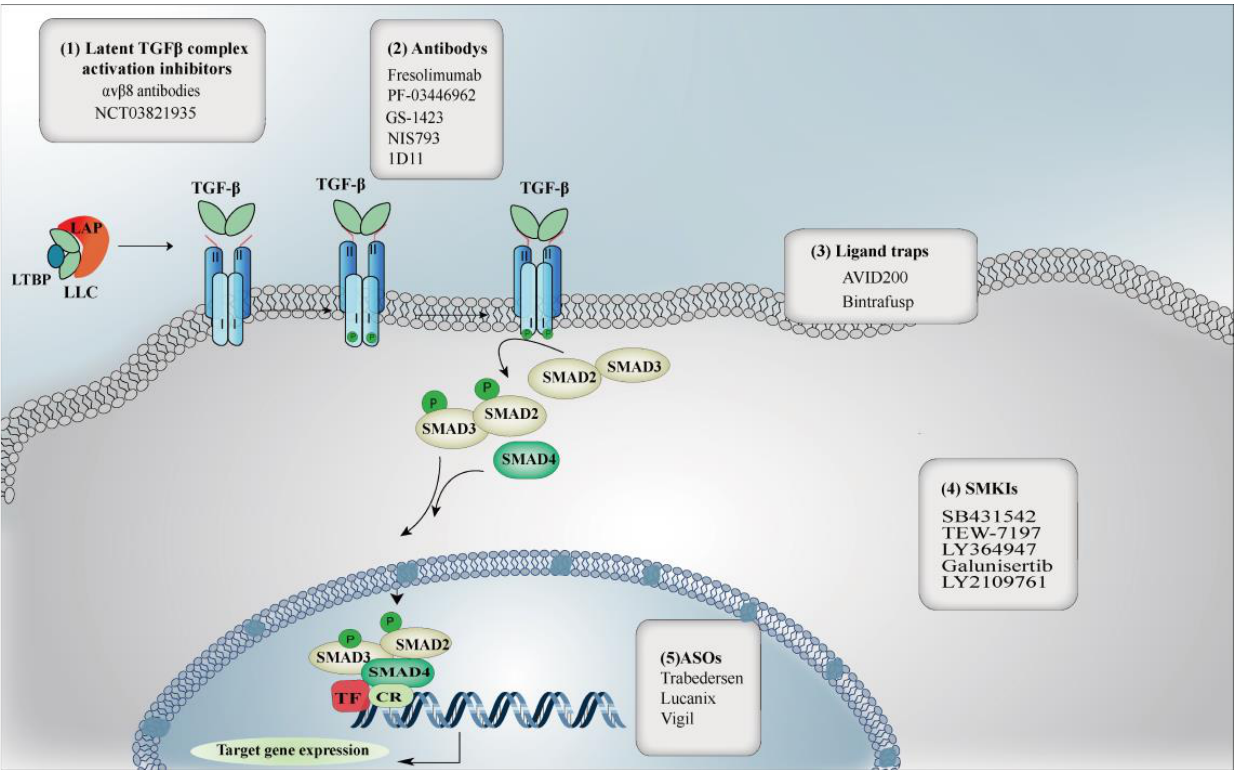
naling [17,23]: (1) The latent TGFβ complex activation inhibitors: avβ8 antibodies and NCT03821935 Figure 1. The representational blockers of the potential design targets along with TGF- β /Smad signal- [24]; (2) TGFβ monoclonal antibodies display outstanding specificity and extracellular mechanism: ing [17,23]: ( 1 ) The latent TGF β complex activation inhibitors: av β 8 antibodies and NCT03821935 Fresolimumab, PF-03446962, GS-1423, NIS793, 1D11; (3) Ligand traps by fusing Fcγ to the extracel- lular domain of TGFβR Ⅱ : AVID200 and Bintrafusp [25]; (4) Small-molecule kinase inhibitors (SMKIs) against TGFβR Ⅰ / Ⅱ as ATP mimetics: SB431542, TEW-7197, LY364947, Galunisertib, LY2109761[26]; (5) Antisense oligonucleotides and antisense RNA (ASOs) to downregulate ligands